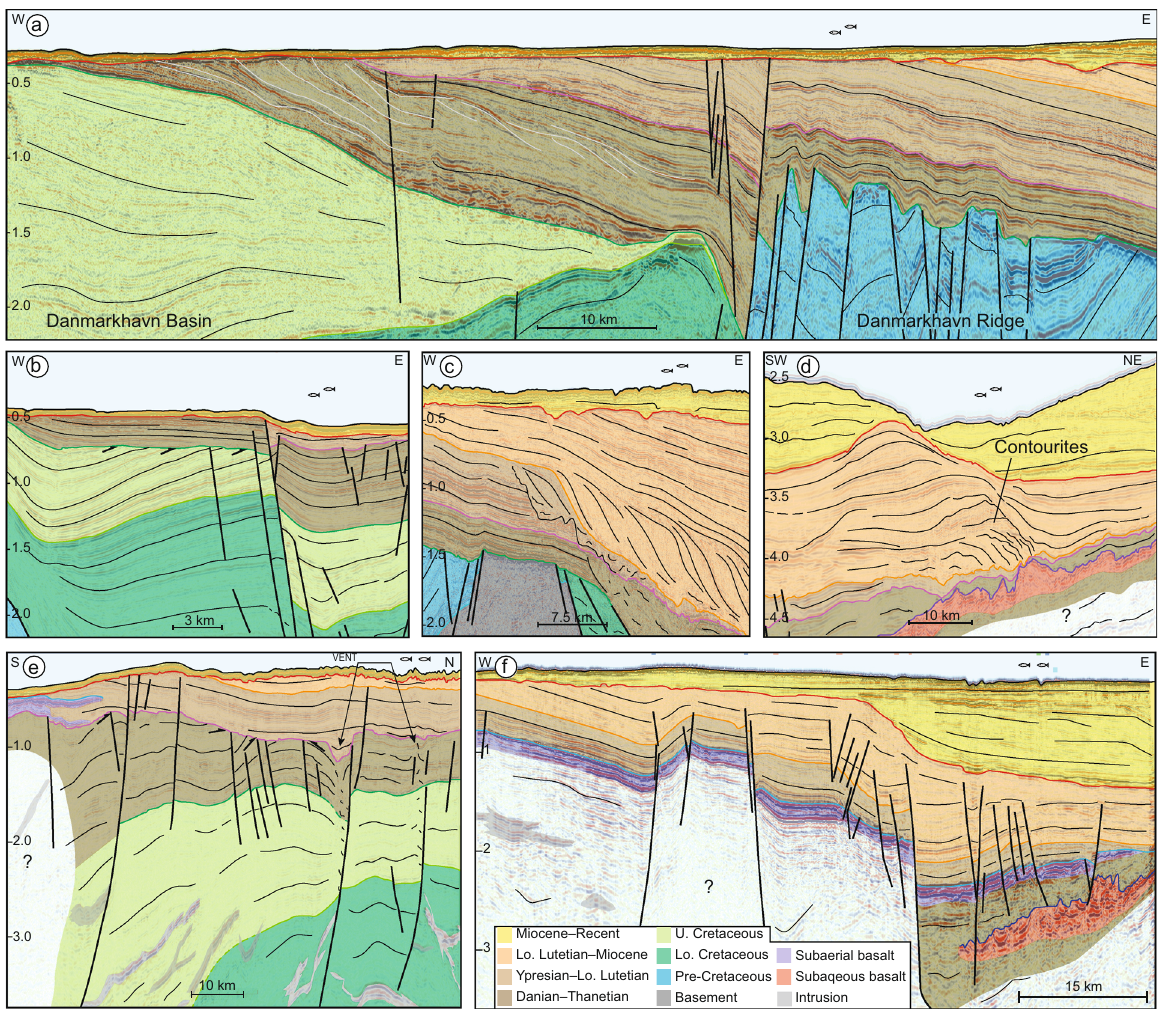
Fig. 3 Offshore seismic examples in two-way travel time. a Maastrichtian – Paleocene clinoforms prograding across the Danmarkshavn Basin and burying the Danmarkshavn Ridge for the fi rst time since the Jurassic. b Top-Cretaceous unconformity related with down-faulting, footwall uplift and rotation (TGS line NEG15-21880). c Earliest Cenozoic burial of the Danmarkshavn Ridge, which consists of Paleozoic strata and basement (TGS line NEG12-2050). d Interpreted Paleocene subaqueous basalt, and further up section, mid-Eocene to recent contourite deposits (ION-GXT line NEG1-5500). See Fig. 1b for location. e Near-top Thanetian unconformity associated with magmatic intrusions, hydrothermal vents, and the onset of subaerial fl ood basalt volcanism (TGS line NEG08-101B). f Danian – Thanetian subaqueous basalt and lower Ypresian subaerial fl ood basalts and Paleocene – Eocene down-faulting (TGS line NEG12- 2040). The color code applies throughout. Correlations between a , c , and d , and core wells treated in the text are presented in Supplementary